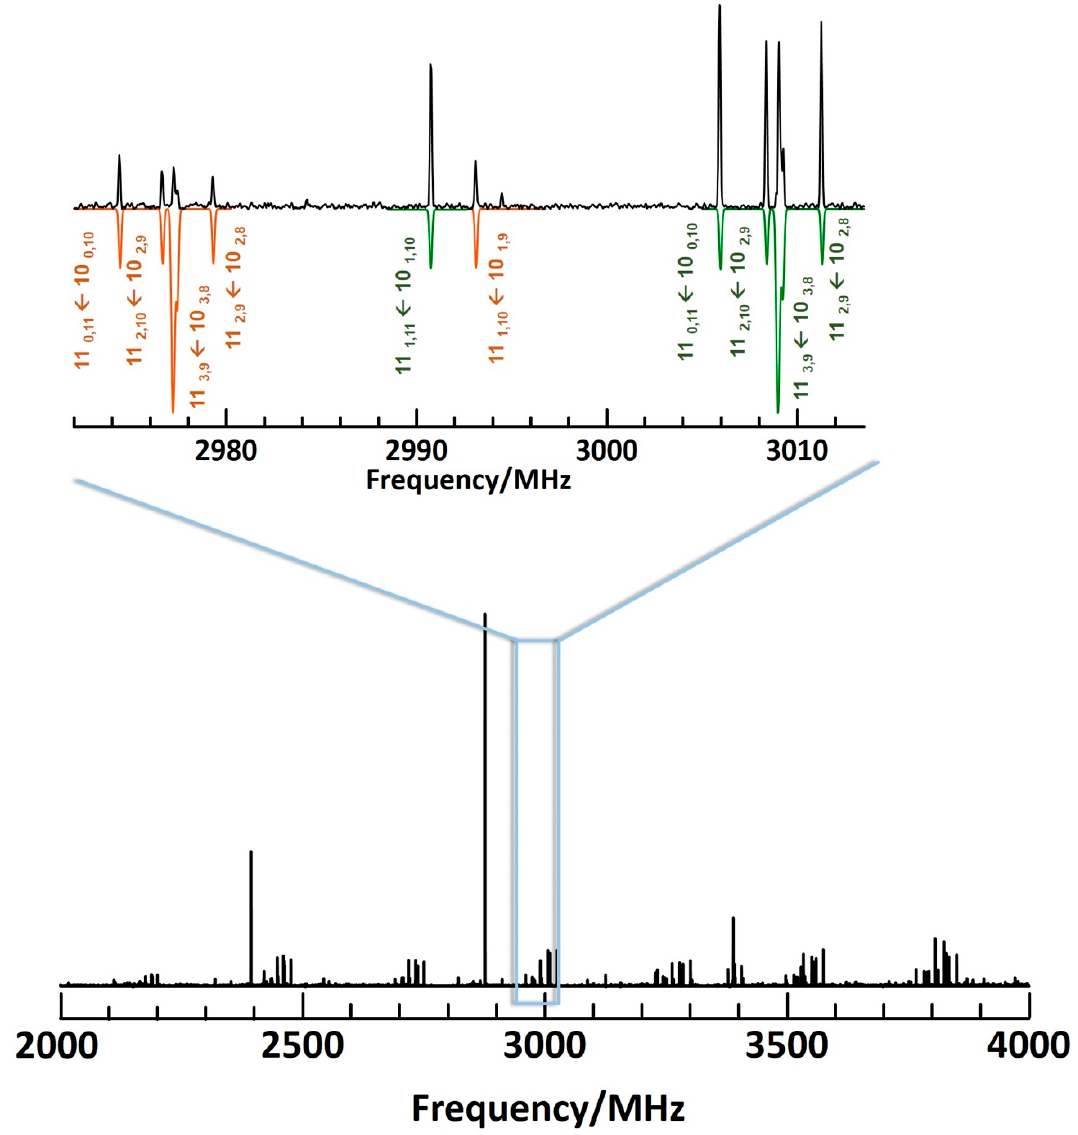
Figure 4. A view of the microwave spectrum of 2-adamantanol in the region 2–4 GHz (lower trace) and a 40 MHz expansion (upper trace) illustrating several typical rotational transitions corresponding to the two isomers of the 2-adamantanol dimer (isomer 1 in green; isomer 2 in orange).